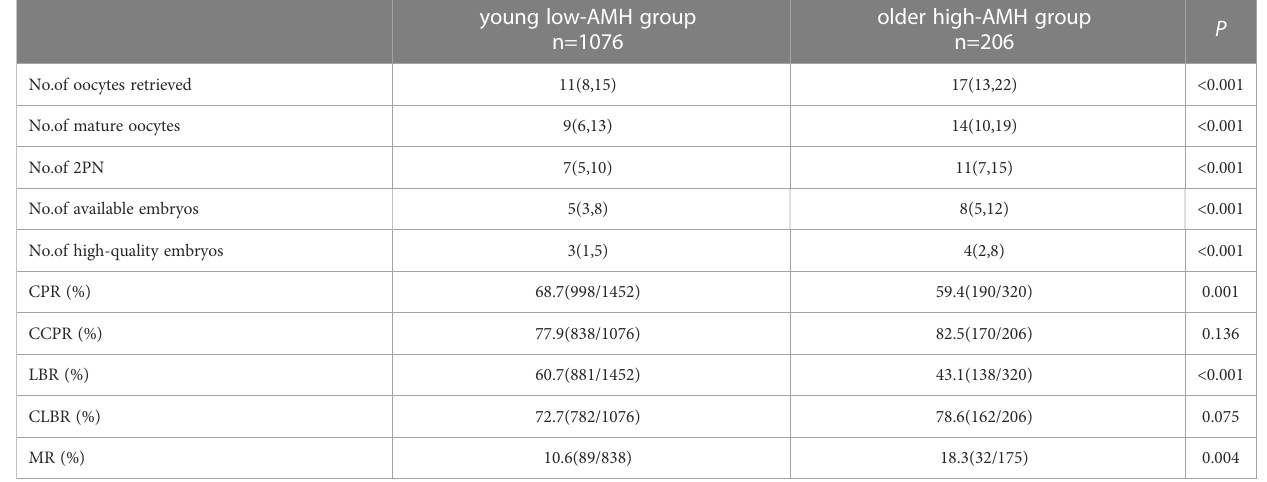
TABLE 2 Laboratory outcomes and ART outcomes between the two